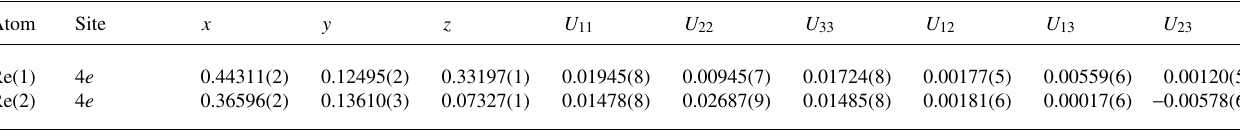
Table 2. Atomic coordinates and displacement parameters (in Å 2 )